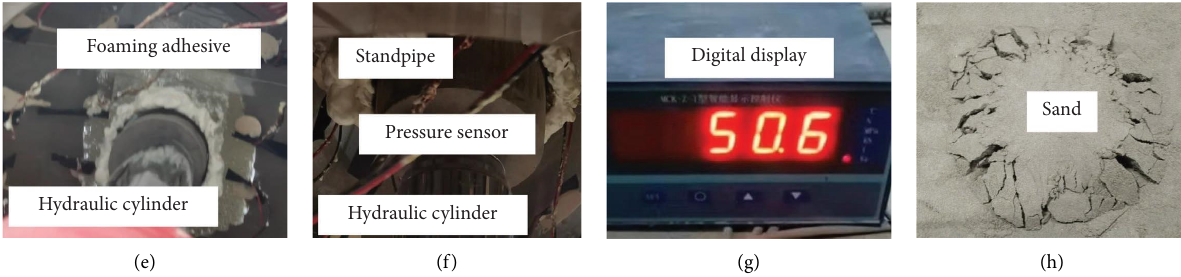
Figure 4: Test process. (a) Marking standpipe. (b) Jacking test. (c) Loading soil. (d) Landflling soil. (e) Painting foaming adhesive. (f) Jacking standpipe. (g) Data recording. (h) Completing jacking.